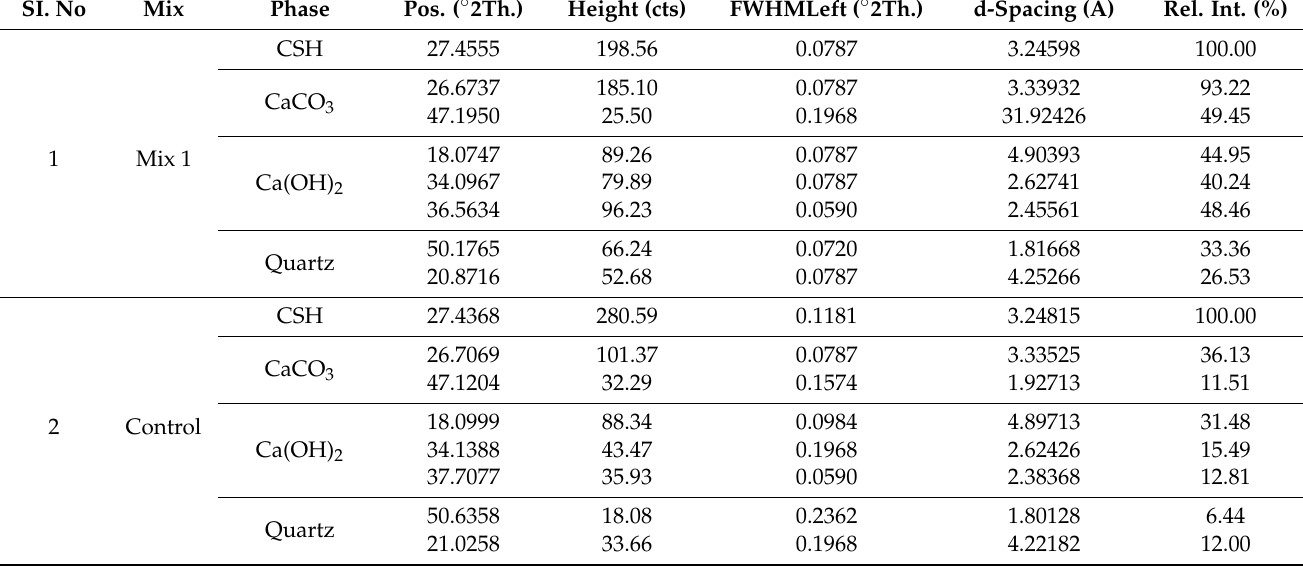
Table 10. Peak list of 28-day hydrated concrete